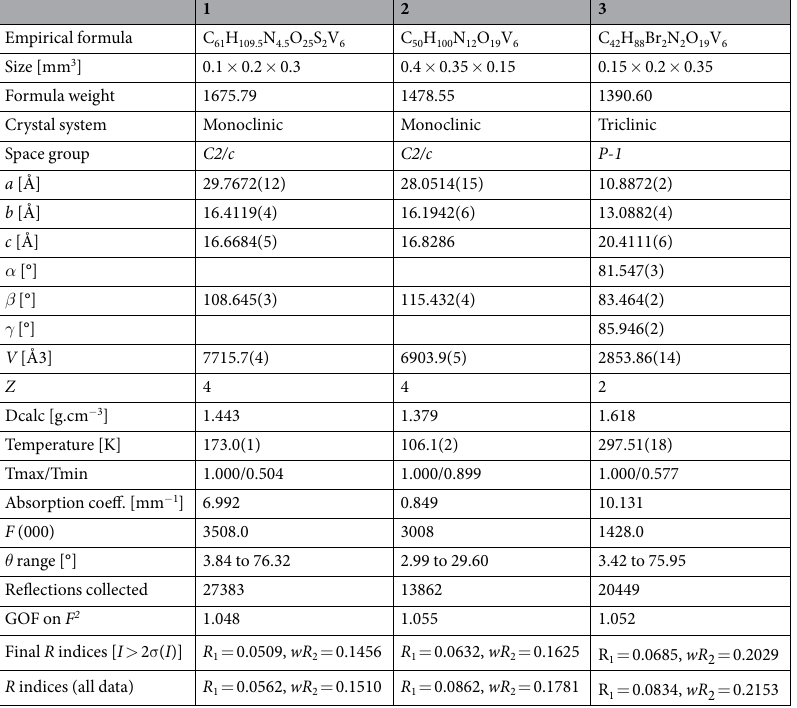
Table 1. Crystallographic data and structure refinement for compounds 1 – 3 . † wR 2 = { Σ [w( F o2 − F c2)2 ]/ Σ [w( F o2)2 ]} 1/2 ;